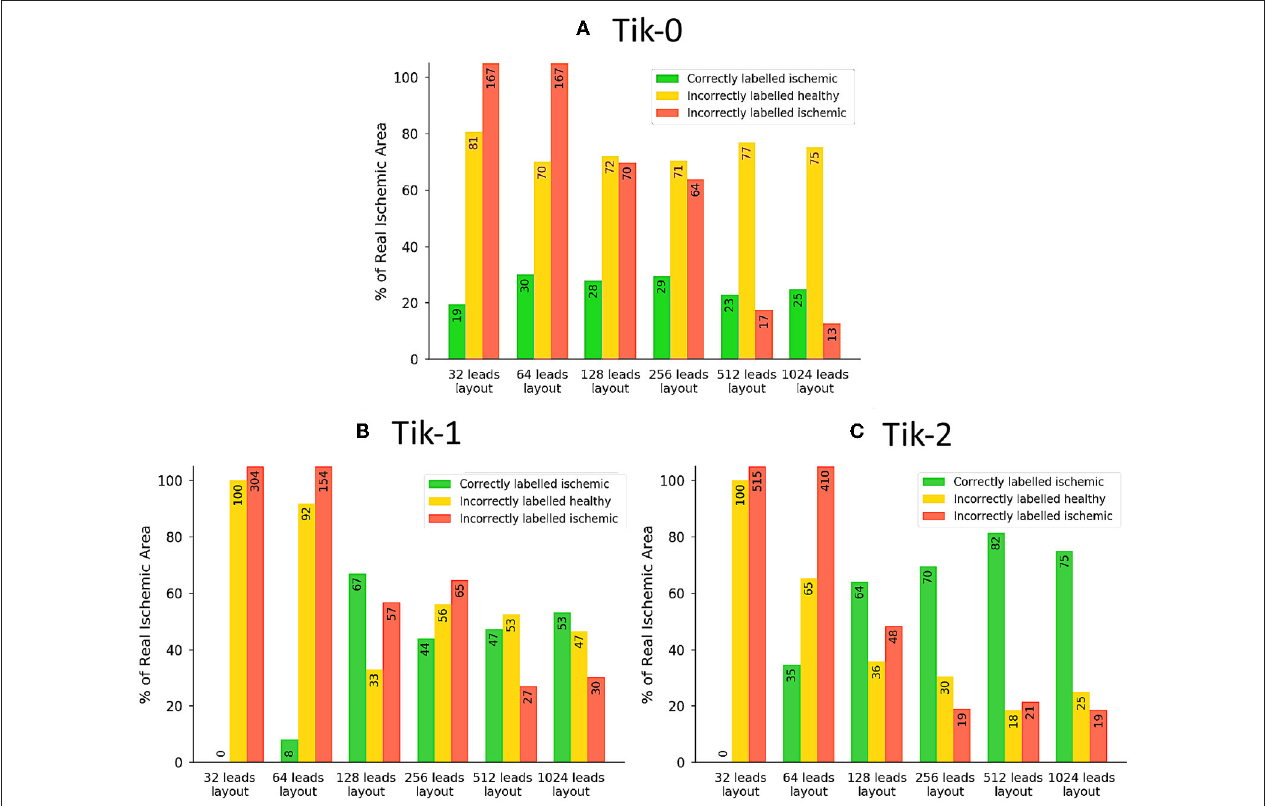
FIGURE 6 | The traffic light data from the ischemic lesion detection visualised as a bar chart. (A) 0 order Tikhonov, (B) 1st order Tikhonov, and (C) 2nd order Tikhonov. Green bars represent the successful identification of the ischemic lesion (correctly ischemic—CI), yellow bars are ischemic which were not identified and shown as healthy (incorrectly healthy—IH) and red bars indicate areas incorrectly identified as ischemic (incorrectly ischemic—II). All area values are represented as a percentage of the real circular lesion. Please note that some bars go above the height of the y axis, bar numbers are present on each bar to aid with this